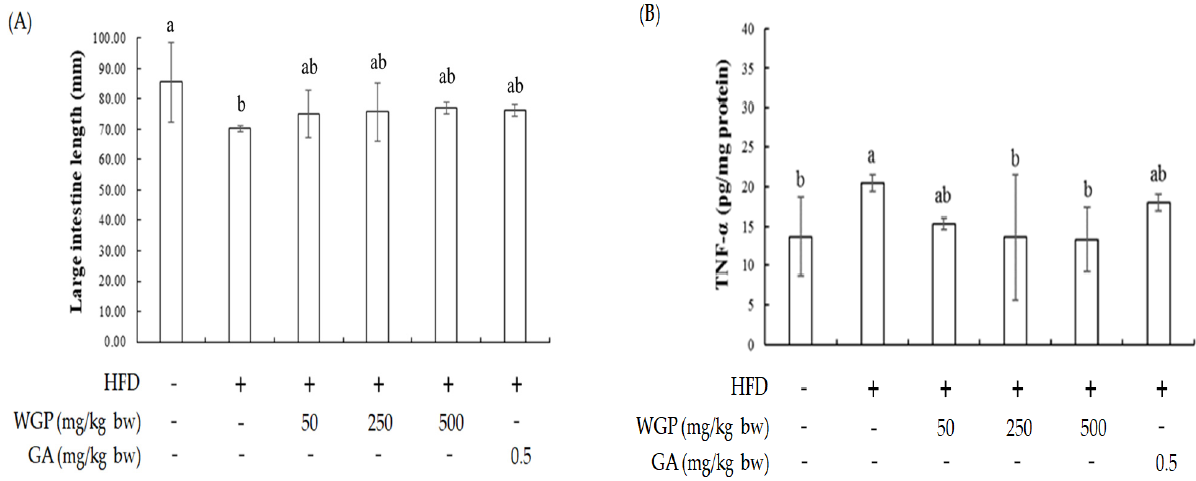
Figure 4. ( A ) Large intestine lengths. ( B ) TNF − α levels in the HFD − induced C57BL/6J mice treated with WGP. The values shown are the means ± SDs ( n = 6). Superscript letters in the same column ( a and b ) denote significant differences ( p < 0.05). GA, gallic acid.